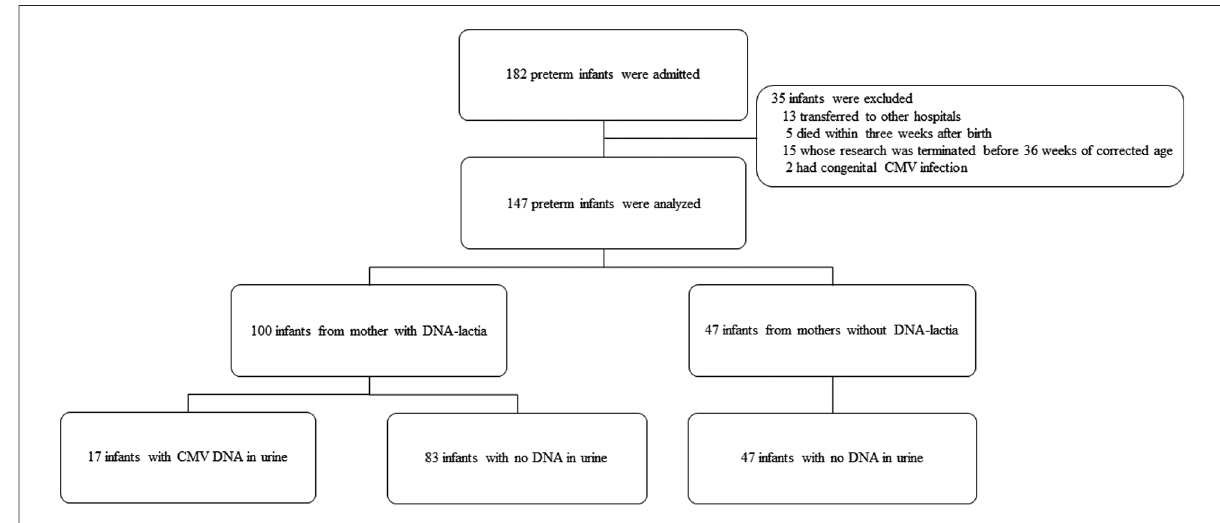
FIGURE 1 Flow diagram showing the enrollment and laboratory testing of the study population. CMV, cytomegalovirus.